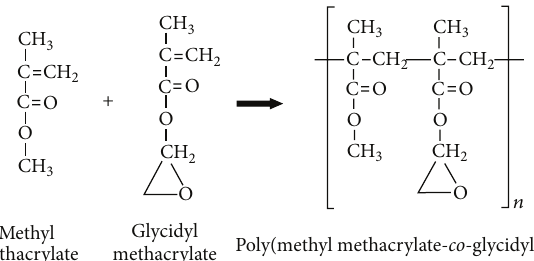
Figure 1: Chemical structure of poly(MMA- co -GMA) cryogel.